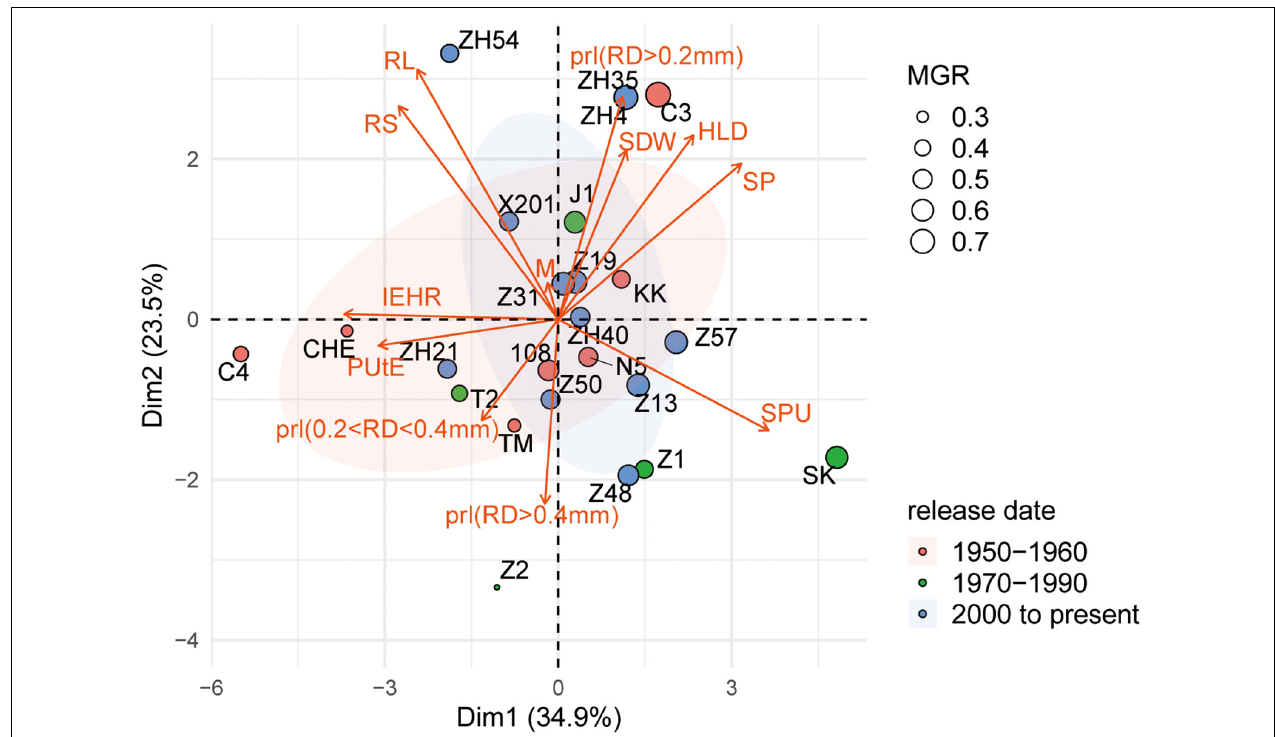
FIGURE 4 | Principal component analysis of plant growth, morphological traits, and mycorrhizal traits of 24 cotton varieties grown under low P supply and inoculated with indigenous AM fungi. Biplot showing scores in the first two principal components (PC1, x -axis; PC2, y -axis) for traits [red arrows: shoot dry weight (SDW), shoot P concentration (P conc.), mycorrhizal colonization indicated by AM fungal gene copy number (M), HLD, root length of different diameters, root diameter (RD), root length (RL), root volume (RV), shoot P (SP) content, P utilization efficiency (PUtE), and specific P uptake (SPU) in shoots by unit of root length]. In addition, we calculated the PRL, the percentage of the root length with different root diameters. Points are colored by release date. The size of point indicates the mycorrhizal growth response (MGR, g), calculated as the difference in SDW in colonized and noncolonized